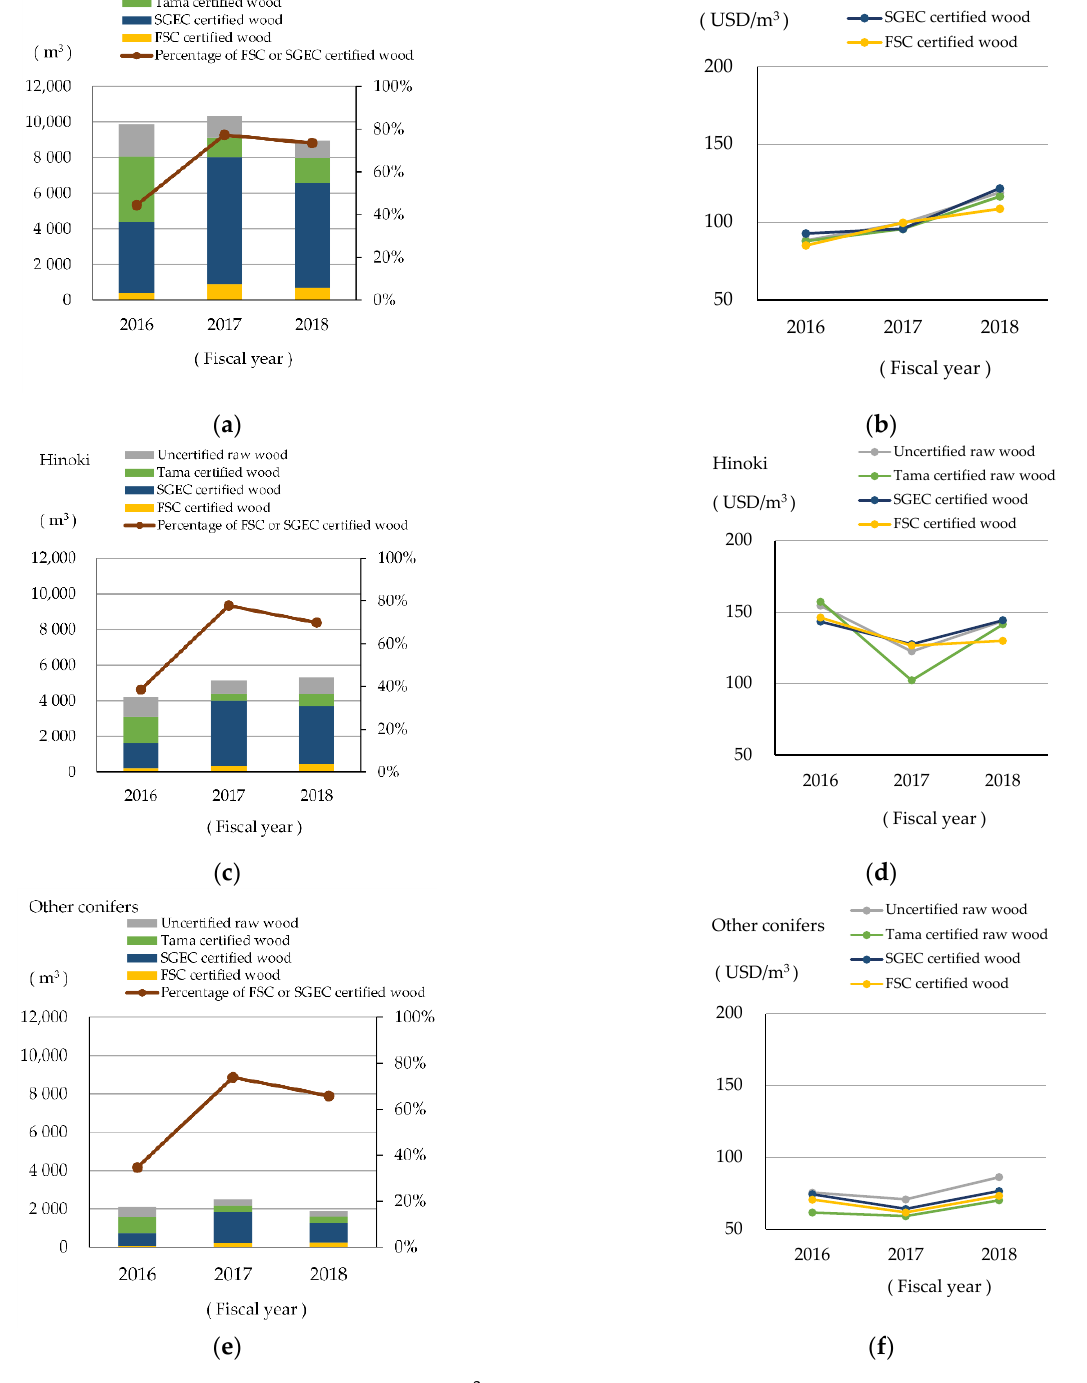
Figure 9. Handling volume and average price (USD/m 3 ) of FSC- and SGEC-certified wood by tree type at Tama Roundwood Market Center. ( a ) handling volume of sugi; ( b ) average price of sugi; ( c ) handling volume of hinoki; ( d ) average price of hinoki; ( e ) handling volume of other conifers; ( f ) average price of other conifers.